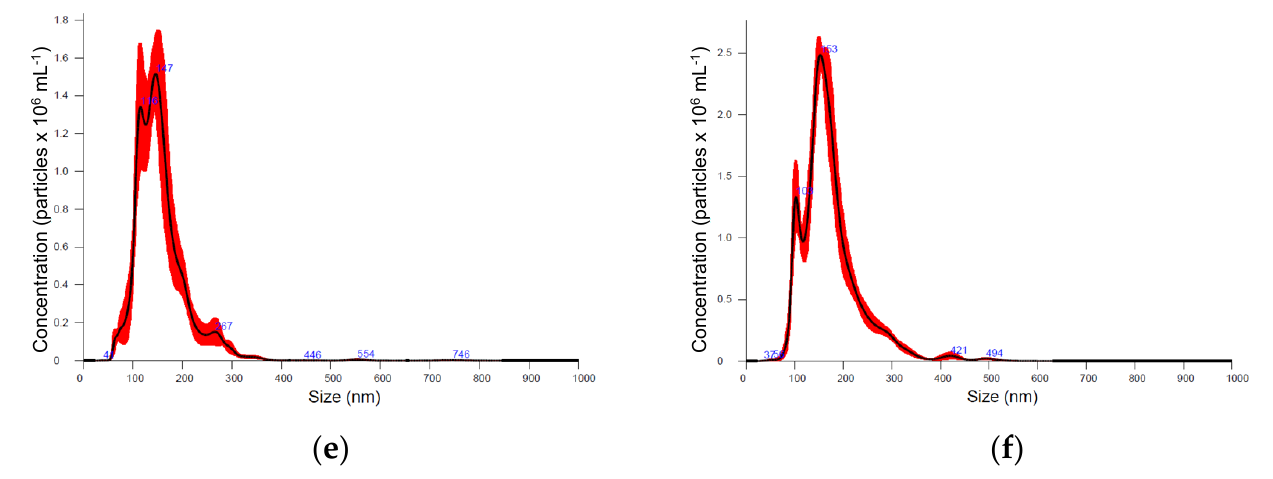
Figure 1. Particle size distribution according nanoparticle tracking analysis (NTA) in different medicinal plant-derived nanoparticle preparations (100 × dilution): ( a ) Kalanchoe daigremontiana , ( b ) Silybium marianum , ( c ) Artemisia absinthium , ( d ) Scutelaria baicalensis , ( e ) Chelidonium majus , and ( f ) Hypericum perforatum . Black lines represent the average value ( n = 5); the width of red band—standard deviation of the particle size distribution ( n = 5). Table 1. Plant-derived nanoparticle yield, size, and number distribution ( x ± SD , n = 5 ) . Different letters within the column indicate statistically significant differences between means according to Tukey’s test at the confidence level p ≤